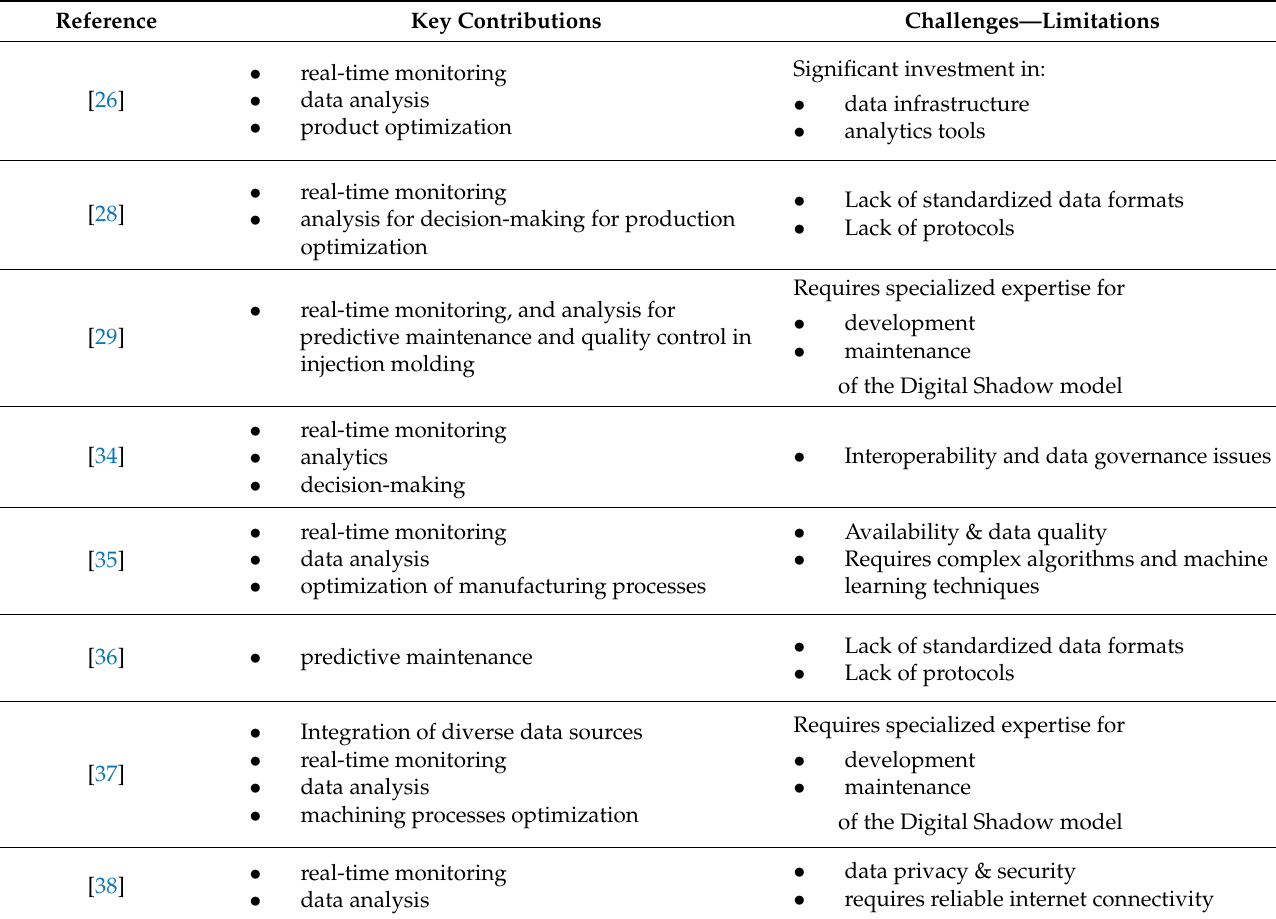
Table 3. Achievements and Limitations Using Digital Shadow